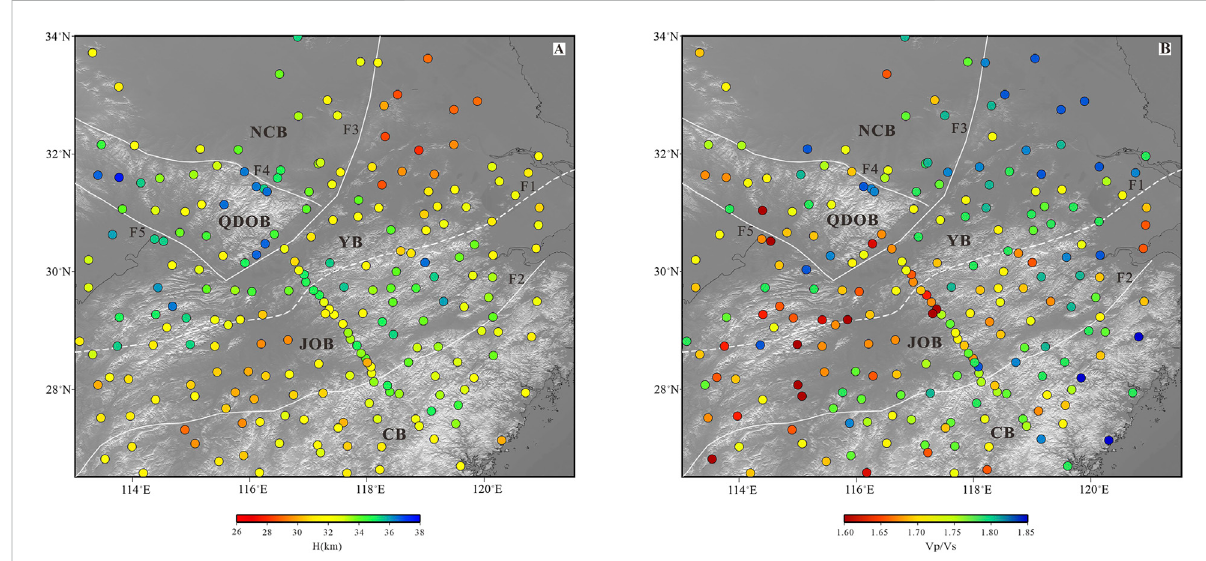
FIGURE 6 Distribution of crustal thickness (A) and Vp/Vs ratio (B) at the stations. Labels are the same as in Figure